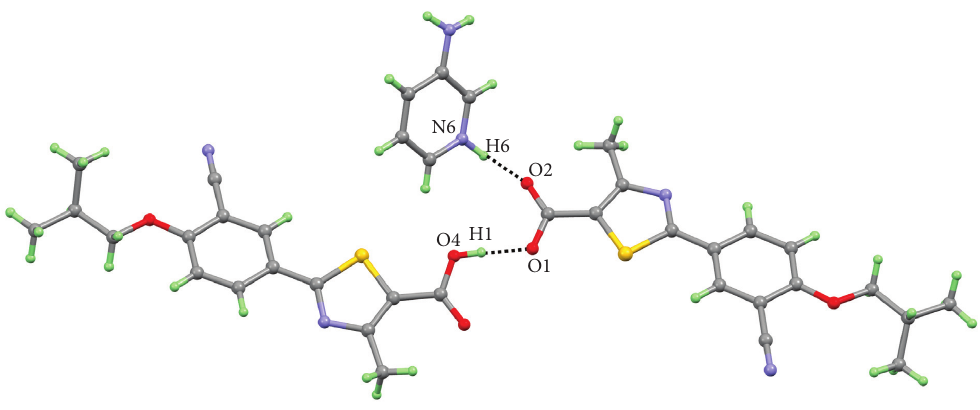
Figure 4: The crystal structures of FEB-3AP salt.